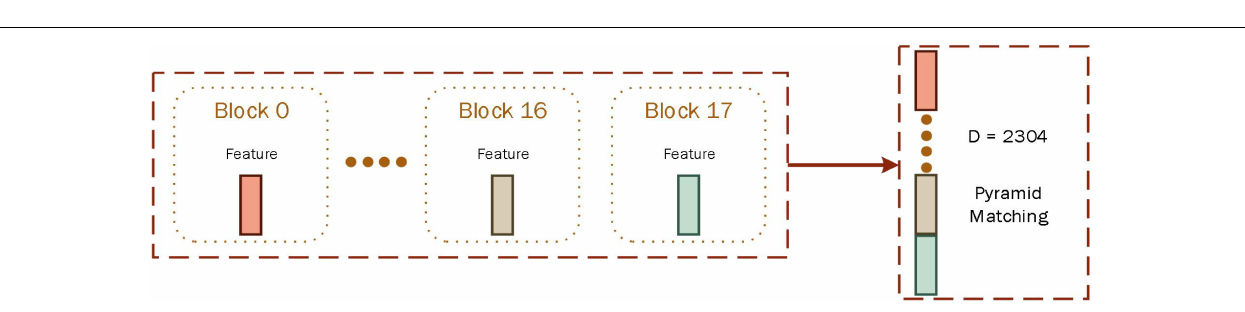
FIGURE 6 | Feature integration module. Features in different blocks are fused, and the fused feature could be used to identify P. trituberculatus .